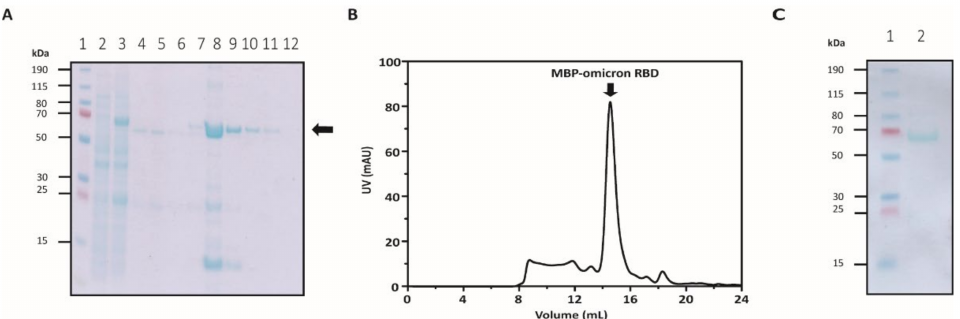
Figure 3. Purification of MBP-RBD omi . ( A ) SDS-PAGE analysis of purified MBP-RBD omi by Ni-NTA. The black arrow indicates the band position of the MBP-RBD omi . The lanes of SDS-PAGE are as follows: lane 1, protein size marker (Thermo); lane 2, cell lysate before IPTG induction; lane 3, cell lysate after IPTG induction; lane 4, periplasmic fraction obtained by osmotic shock; lane 5, Ni-NTA flow through fraction; lane 6, Ni-NTA wash fraction; lane 7 to 12, Ni-NTA elution fractions. ( B ) Size- exclusion spectrum of MBP-RBD omi monitored at 280 nm. The black arrow indicates the position of MBP-RBD omi fractions. ( C ) SDS-PAGE analysis of purified MBP-RBD omi by size-exclusion. The lanes of SDS-PAGE are as follows: lane 1, protein size marker (Thermo); lane 2, purified MBP-RBD omi